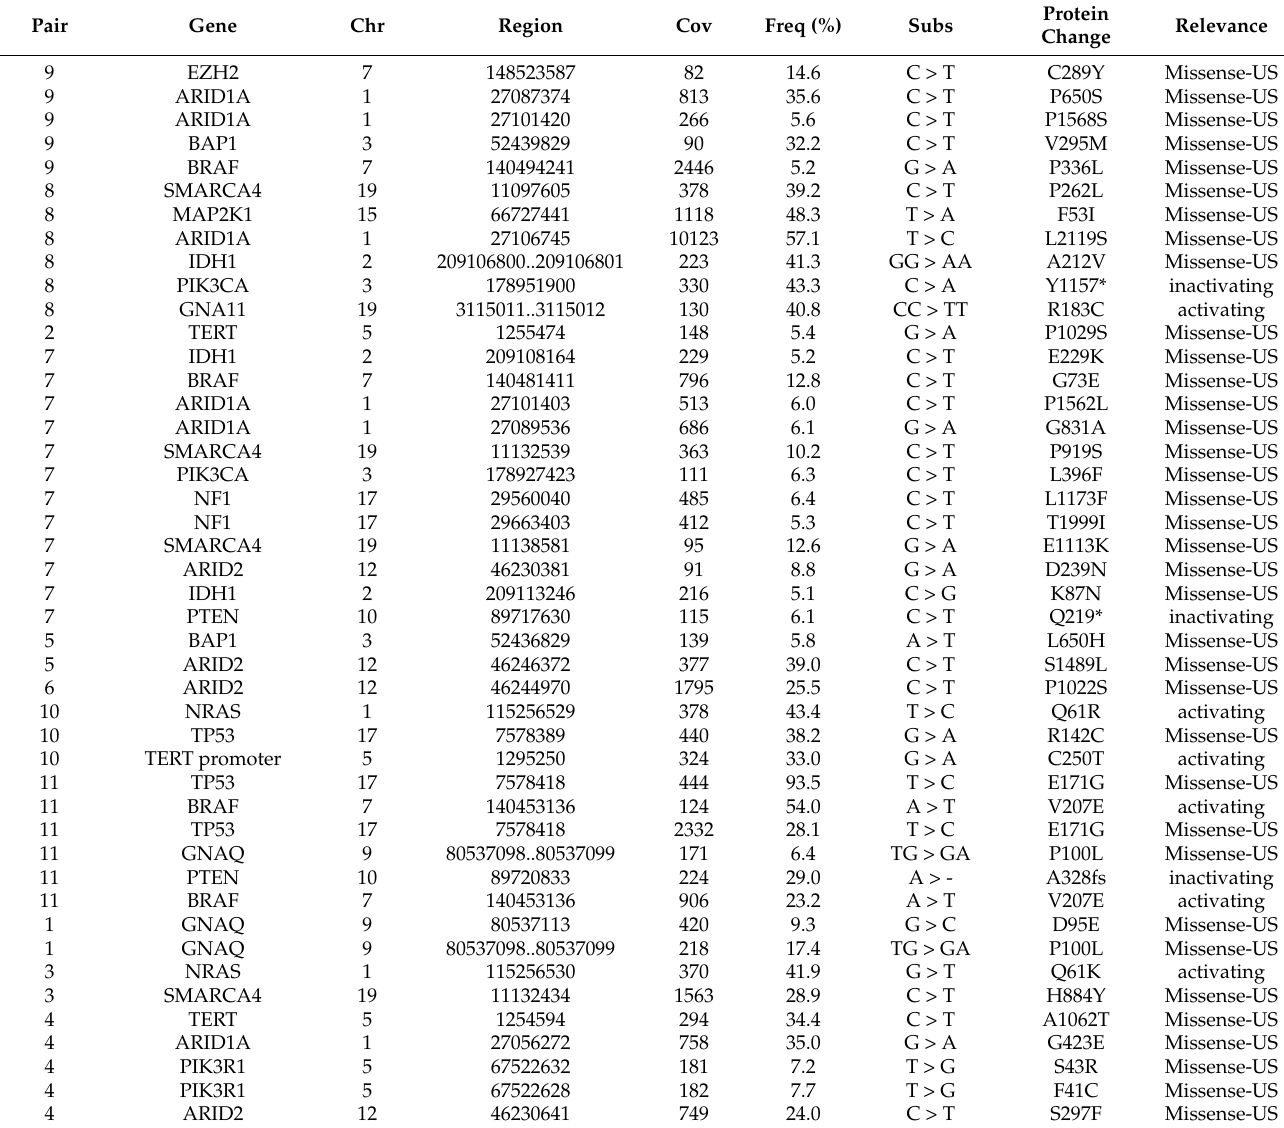
Table 2. Variants specific to brain-metastases of